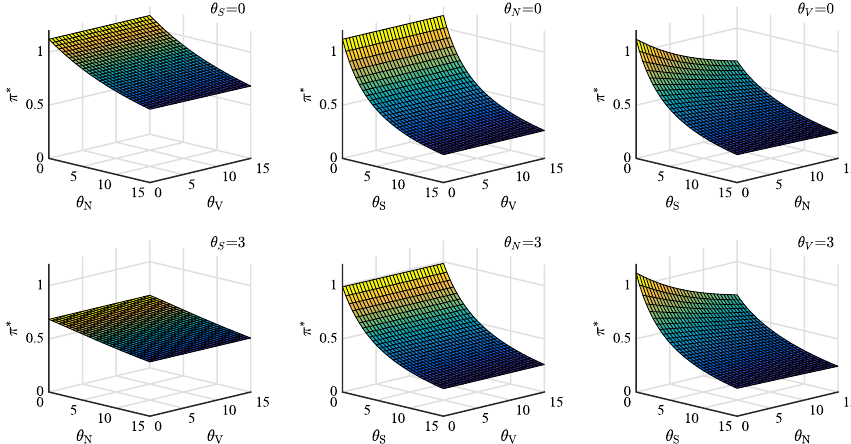
Fig. 2 Optimal portfolio choice in stock market as a function of ambiguity aversion parameters θ S , θ V and θ N . Panel ( a ), ( b ), and ( c ) set θ S , θ N and θ V as 0, respectively. By contrast, Panel ( d ), ( e ), and ( f ) set θ S , θ N , and θ V as 3,